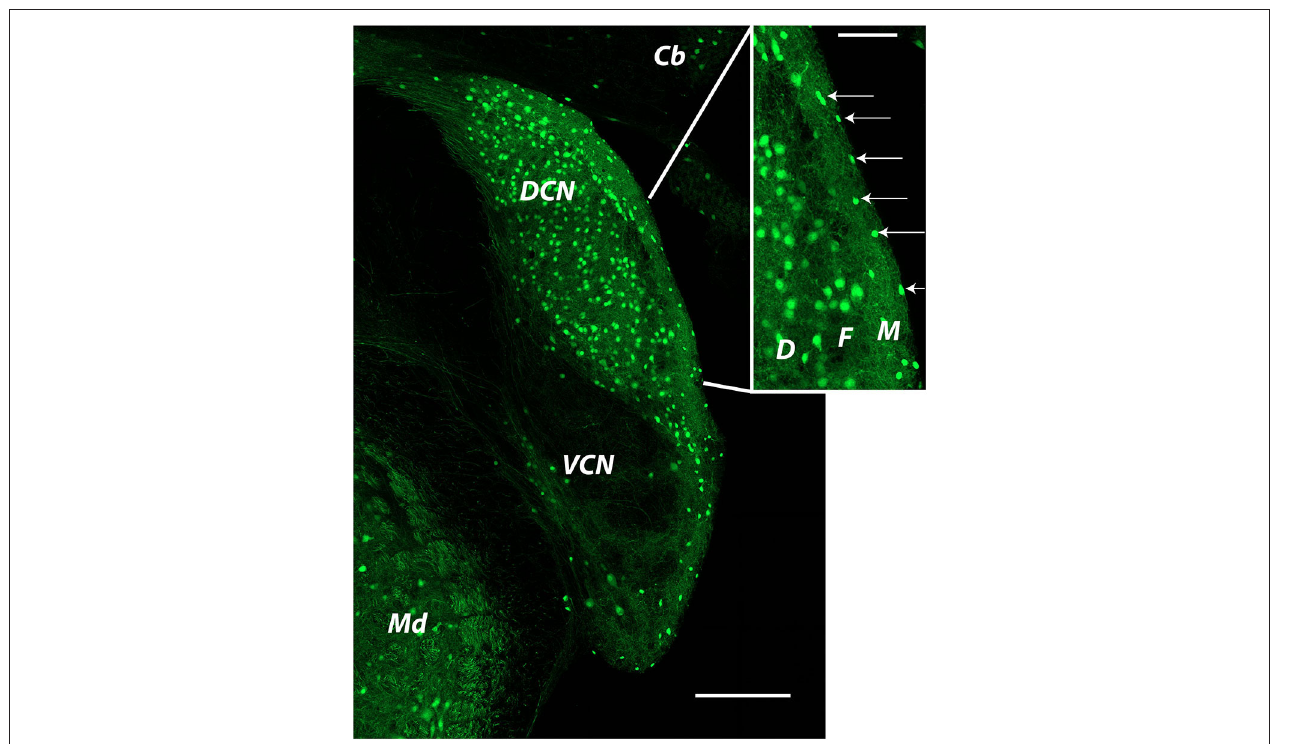
molecular layer. Cells used for recordings were most often those closest to the edge of the brain stem at the ependymal layer. Cb: cerebellum; DCN: dorsal cochlear nucleus; Md: medulla; VCN: ventral cochlear nucleus. Inset: D: deep layer; F: fusiform cell layer; M: molecular